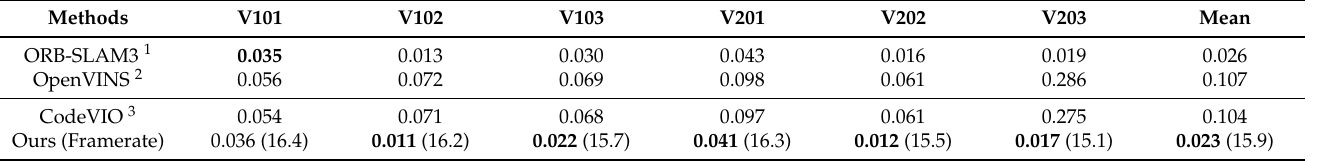
Table 3. Trajectory evaluation of monocular visual-inertial SLAM systems with light-weight networks for local dense mapping on the Vicon room sequences of EuRoC dataset (RMSE of ATE in meters: m). Framerate results are in FPS. The best is shown in